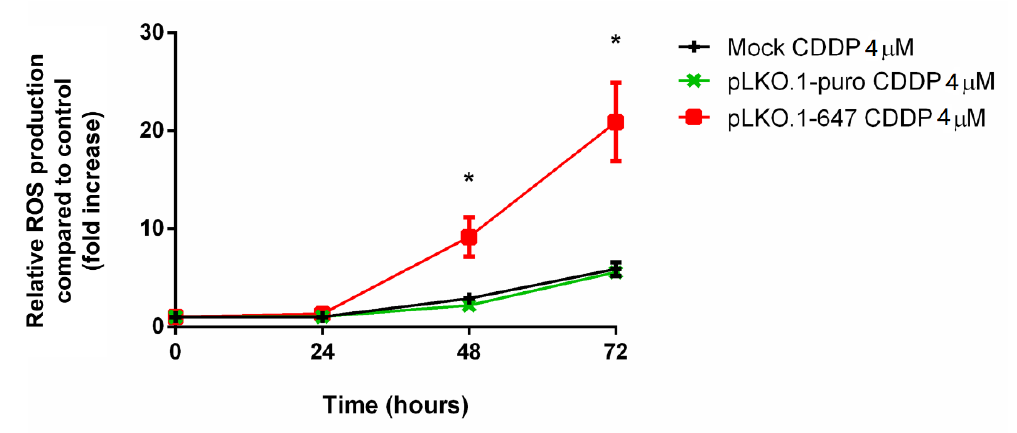
Figure 4. Intracellular reactive oxygen species (ROS) levels in A375 cells upon CDDP treatment. ROS levels were determined in mock, A375 transfected with empty vector (pLKO.1-puro), and PON2 downregulating cells (pLKO.1-647) upon treatment with CDDP (4 µM) at different time points (0, 24, 48, and 72 h). All values are expressed as the mean ± standard deviation (* p < 0.05).